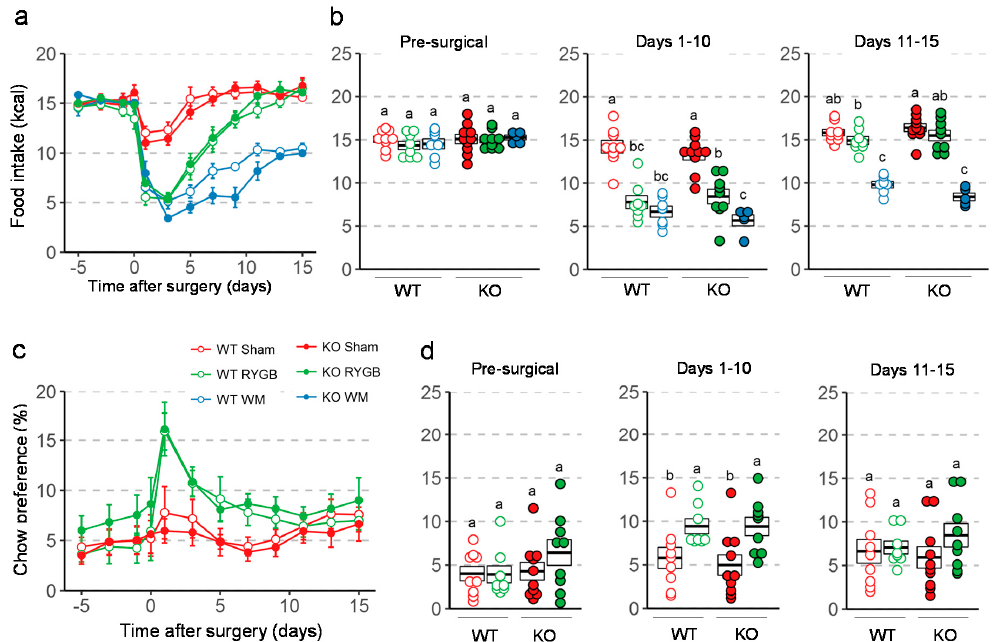
Figure 3. Effect of RYGB, sham surgery, or weight matching to RYGB by caloric restriction (WM) on food intake and diet preference in Y2RKO and WT mice. All mice were on a two-choice diet consisting of high-fat and regular (low-fat) chow. ( a ): Daily food intake before and for 15 days after surgery. ( b ): Average daily food intake over three distinct periods: pre-surgical (5 days before surgery), recovery (days 1–10 after surgery), and stable period (days 11–15 after surgery). ( c ): Daily chow preference before and for 15 days after surgery. Preference is expressed as percent calories obtained from chow diet. WM mice were given a fixed percent of calories from chow so their data is not shown. ( d ): Average daily chow preference over the same periods as in b. Data in a and c are presented as means ± SEM. Data in b and d are presented as individual data points over a box showing means ± SEM. Groups that do not share the same letters are significantly different from each other ( p < 0.05, pairwise t-tests with Benjamini–Hochberg correction, FDR = 0.05).